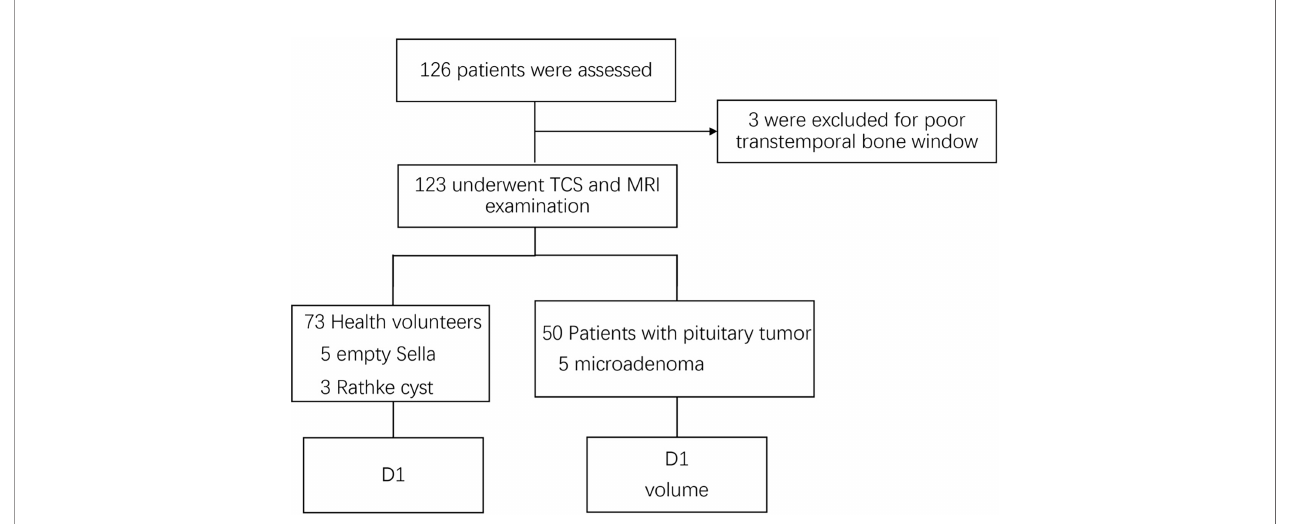
FIGURE 2 | Flow diagram of the inclusion of patients in the study. D1, transverse diameter.